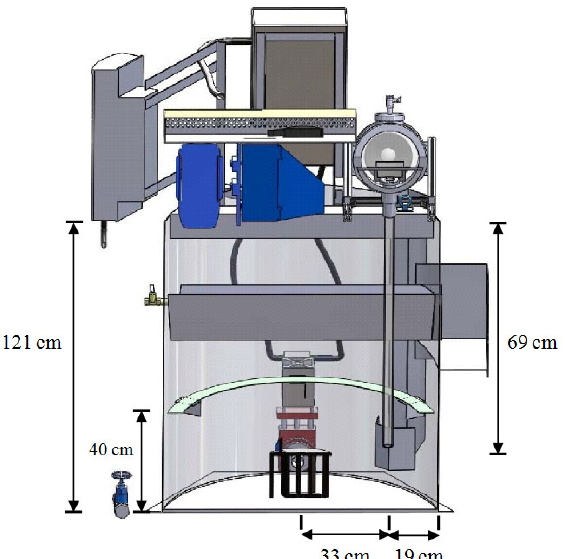
Figure 2. A cut-away view of Metso RCS TM 0.8 m 3 mechanical cell showing dimensions and location of McGill Bubble Size Analyzer (MBSA) sampling